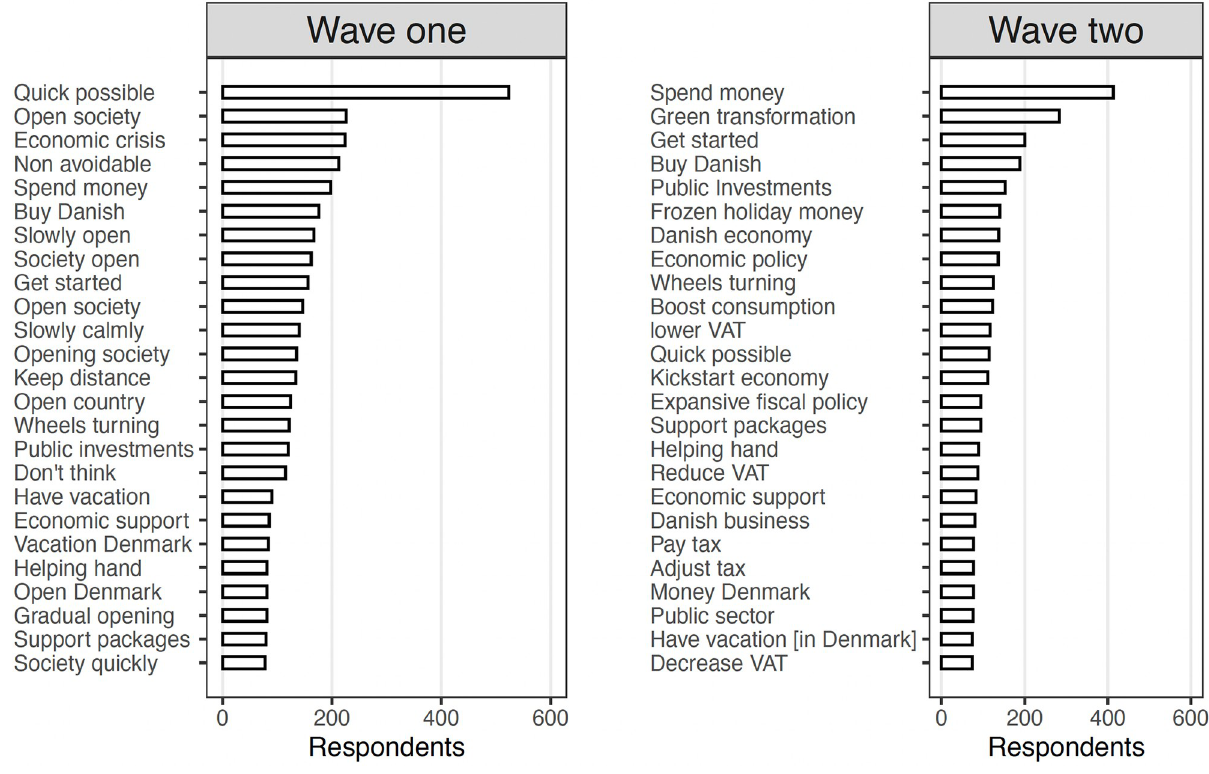
Fig 2. Most common bigrams in open-ended answers across the two